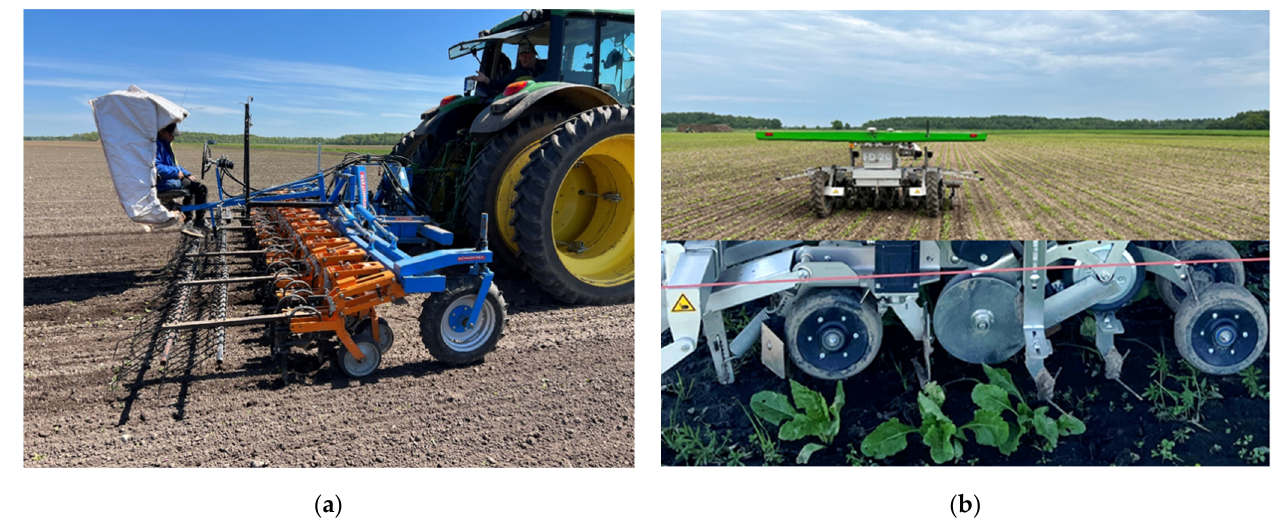
Figure 1. Machines used for sugar beet weed control: ( a ) conventional system—Schmotzer inter-row cultivator; ( b ) robotic system—FD20 robot (FarmDroid).